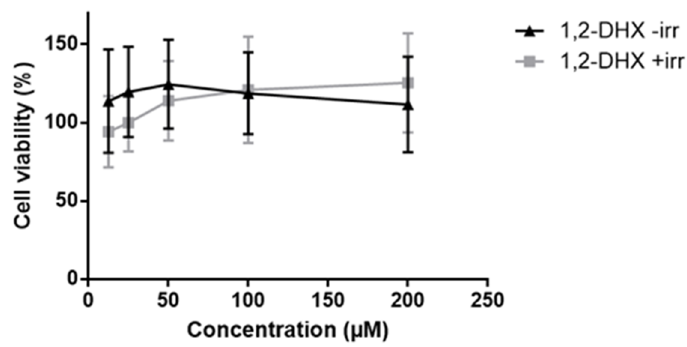
Figure 4. Cell viability of the HaCaT cell line exposed to 1,2-DHX ( 1 ; 12.5, 25, 50, 100, and 200 µM) for the evaluation of phototoxicity by the HaCaT NRU assay. Data are presented as mean ± SD (n = 3) relative to solvent control, with (+irr) = 100 ± 20.5 ( n = 3) and (-irr) = 100 ± 16.9 ( n = 3). Data were analyzed using one-way ANOVA with a Dunnett post hoc test.